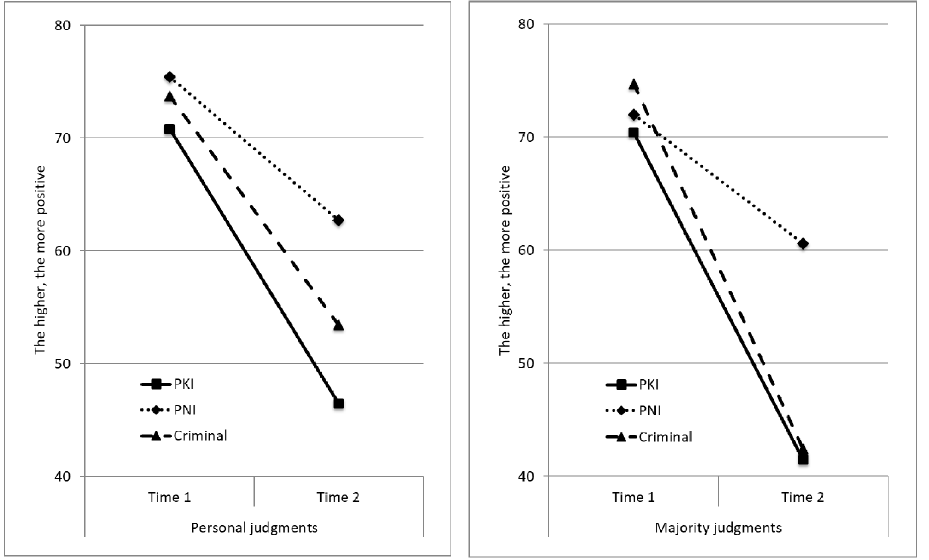
Figure 1. Mean estimates of positive judgments in Study